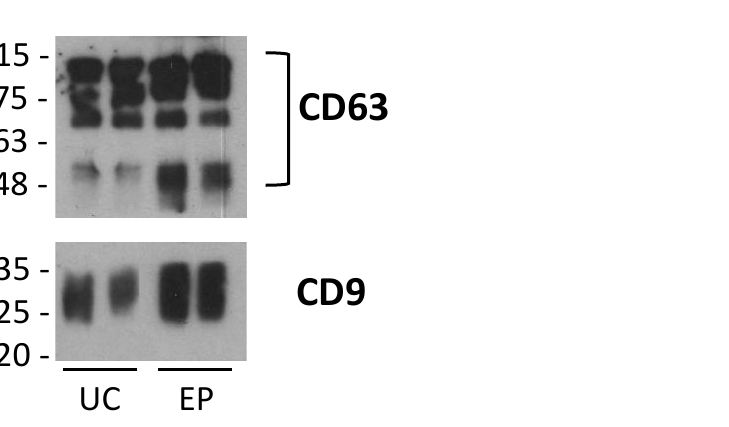
Figure 1. Analysis of sEV-associated DNA isolated from plasma of metastatic colorectal cancer (mCRC) patients. Upper panel: Schematic representation of the spotted barcode probe array; middle panel: Cy3 fluorescence images of the analysis of sEV DNA from plasma of patient 7, 13 and 14. The barcode probes corresponding to KRAS G12C, KRAS A146T, and KRAS G13D as attended for these patients are highlighted in yellow. In orange is highlighted the KRAS G12D mutation that was not detectable in ctDNA [14]. Lower panel: 2-D fluorescence amplitude plot generated by QuantaSoft™ software from plasma EVs of patient 7, 13 and 14 and respective fractional abundance of the mutated KRAS allele. Mutant sequences are clustered in the top center with high FAM fluorescent intensities (blue dots in the blue circle), wild-type sequences are clustered in lower right corner with high HEX fluorescent intensities (green dots in the green circle), while mutant plus wild-type sequences are clustered in the upper right corner (orange dots in the orange circle). The black cluster on the plot represents the negative droplets.